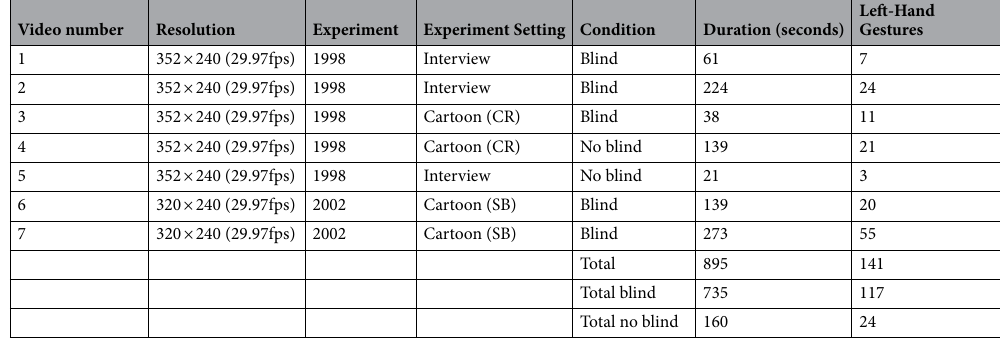
Table 1. Information available data. Experiment setting refers to what IW was talking about, cartoon CR = retelling ‘canary row’, cartoon SB = retelling ‘snow